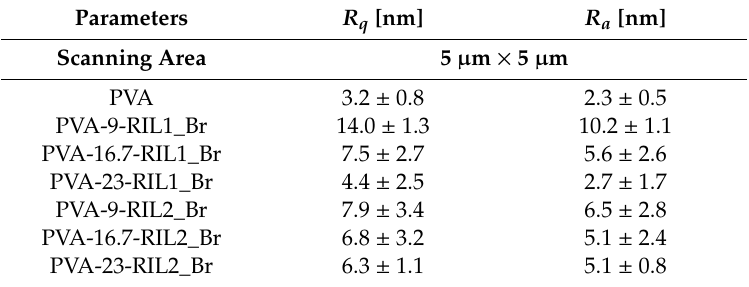
Table 3. Roughness Parameters ( R q and R a ) of pristine PVA and PVA-based membranes with RIL1_Br and RIL2_Br.